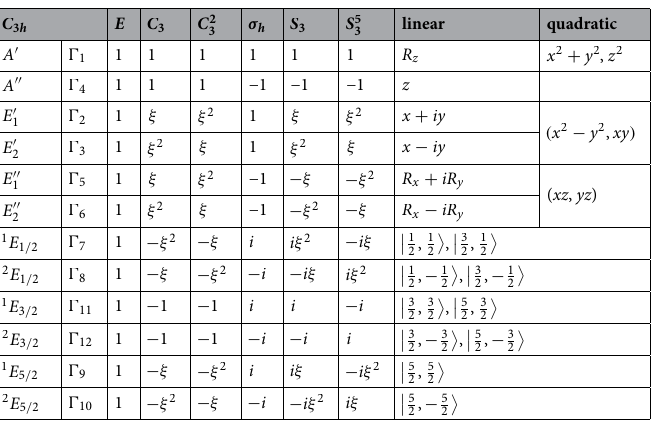
1 . Two common notations are used for the IRs = 1 E 2 E E E E A E E A A E E , A 1 / 2 1 / 2 (cid:31) 1 / 2 , ′ 1 (cid:31) ′′ 1 ′′ 2 → ′′ 1 (cid:31) ′ 2 , ′′ 2 , ′ , ′ → ′′ , ′′ → → → 1 E 2 E E 5 / 2 5 / 2 (cid:31) 5 / 2 →